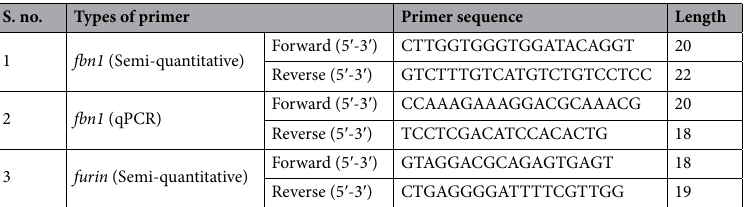
Table 2. Primers used for the reverse transcriptase Polymerase Chain reaction (RT-PCR) and qPCR.